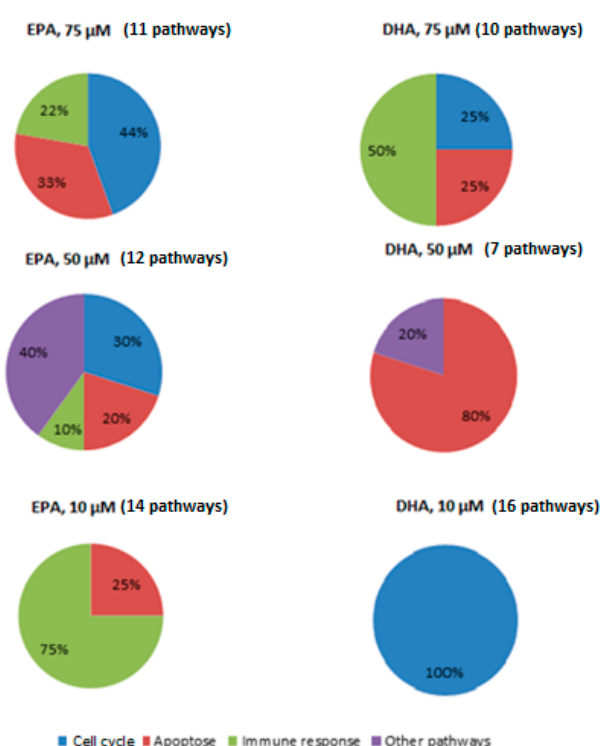
Figure 1. Proportion of activated pathways in LPS-stimulated macrophages incubated with EPA or DHA. The effect of 75, 50, and 10 µ M of EPA or DHA on the proportion of modulated pathways belonging to different families ( immune response , apoptosis , cell cycle , and other pathways ) was investigated in LPS-stimulated macrophages.